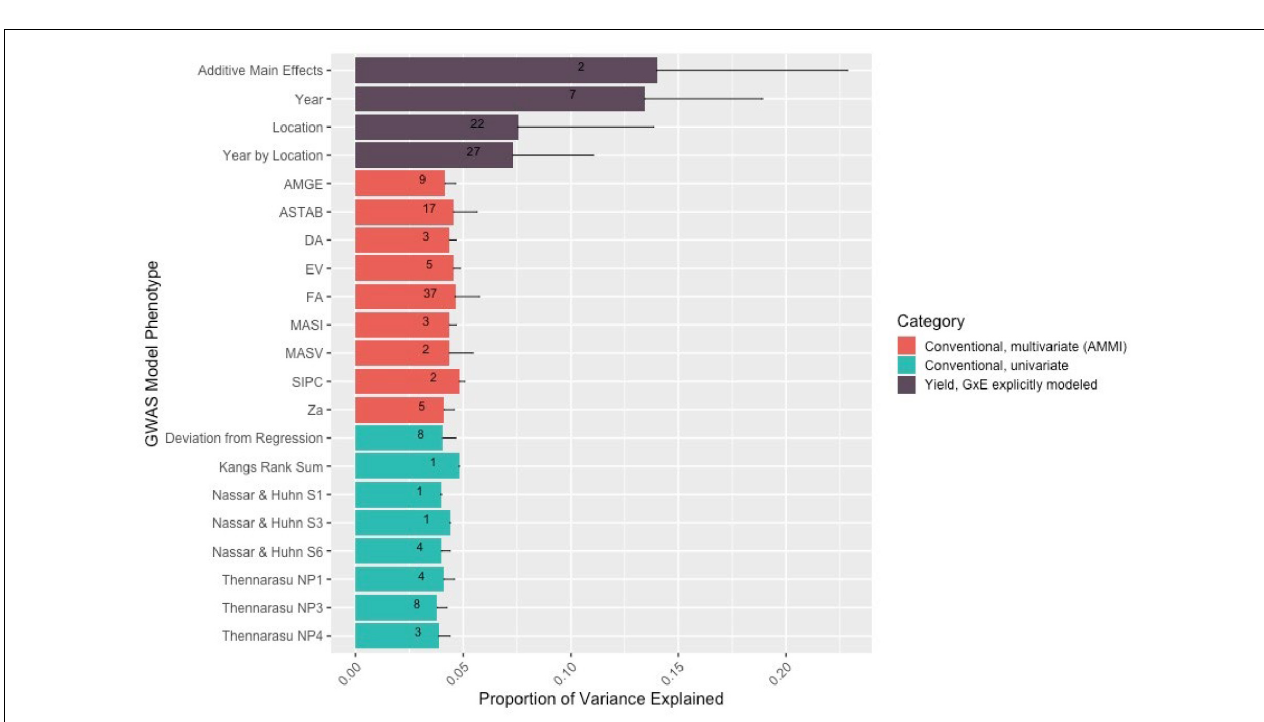
FIGURE 2 | Independent QTL discovered using conventional measures as a GWAS phenotype share very little overlap with loci significant in the explicit GxE model.